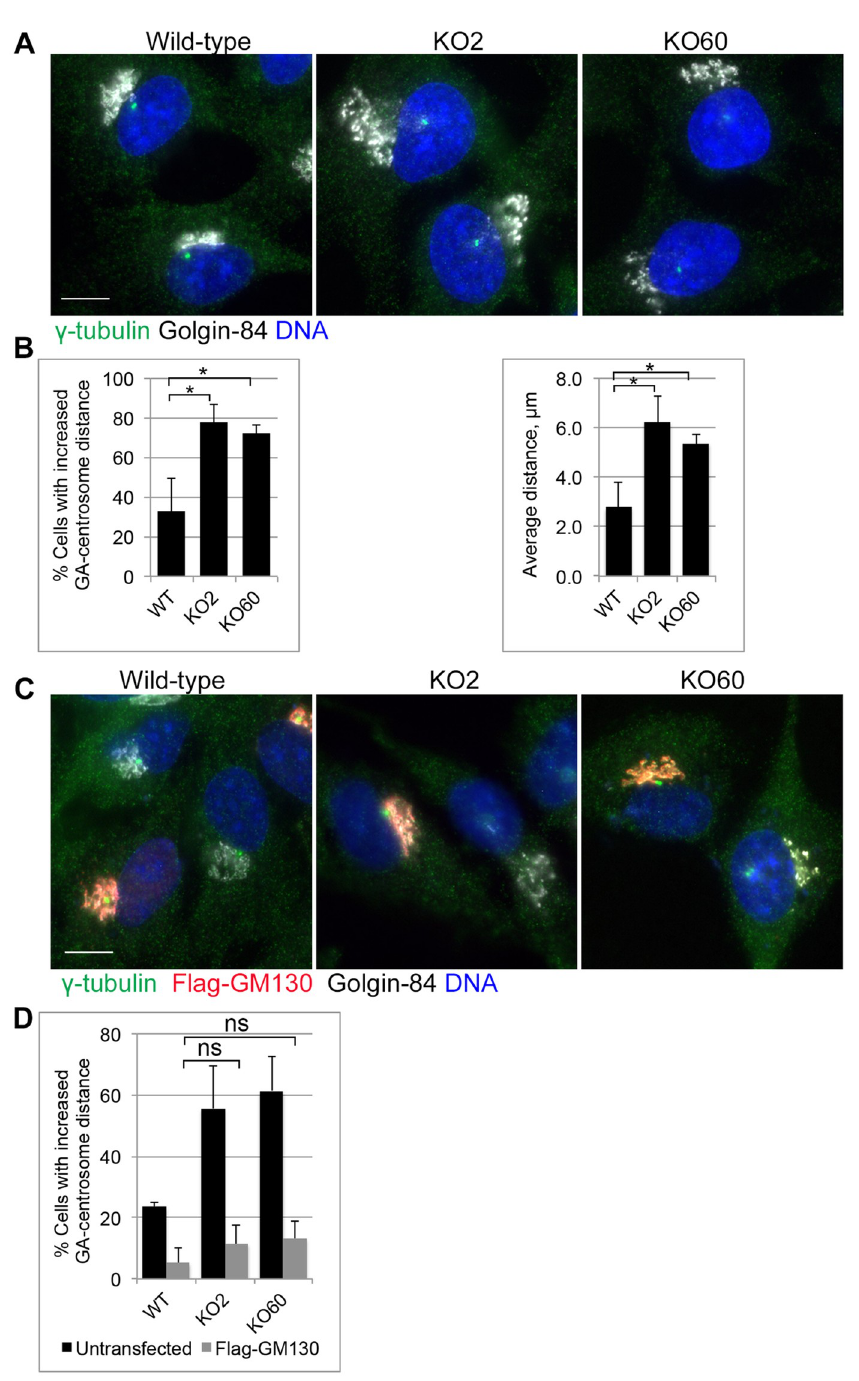
Fig 3. GM130 controls Golgi-centrosome proximity. A . Wild-type and GM130 KO cells were stained for γ -tubulin and Golgin-84 to visualize the centrosome and the Golgi, respectively. B . Left: Graph showing the percentage of cells with increased Golgi (GA)—centrosome distance. The data is from four independent experiments, with at least 50 cells per condition analyzed. p = 0.006 (KO2) and 0.0014 (KO60). Right: Graph showing the average distance between the centrosome and the nearest Golgi edge. p = 0.0029 (KO2) and 0.0031 (KO60). C . Wild-type and GM130 KO cells were transfected with a construct encoding for full length Flag-GM130 and stained for the presence of the Flag tag, γ -tubulin and Golgin-84 to visualize transfected cells, the centrosome and the Golgi, respectively. D . Graph showing the percentage of cells (untransfected and transfected) with increased Golgi-centrosome distance. The data is from four independent experiments with at least 40 cells analyzed per experiment. ns = not statistically significant. Scale 10 μ m.